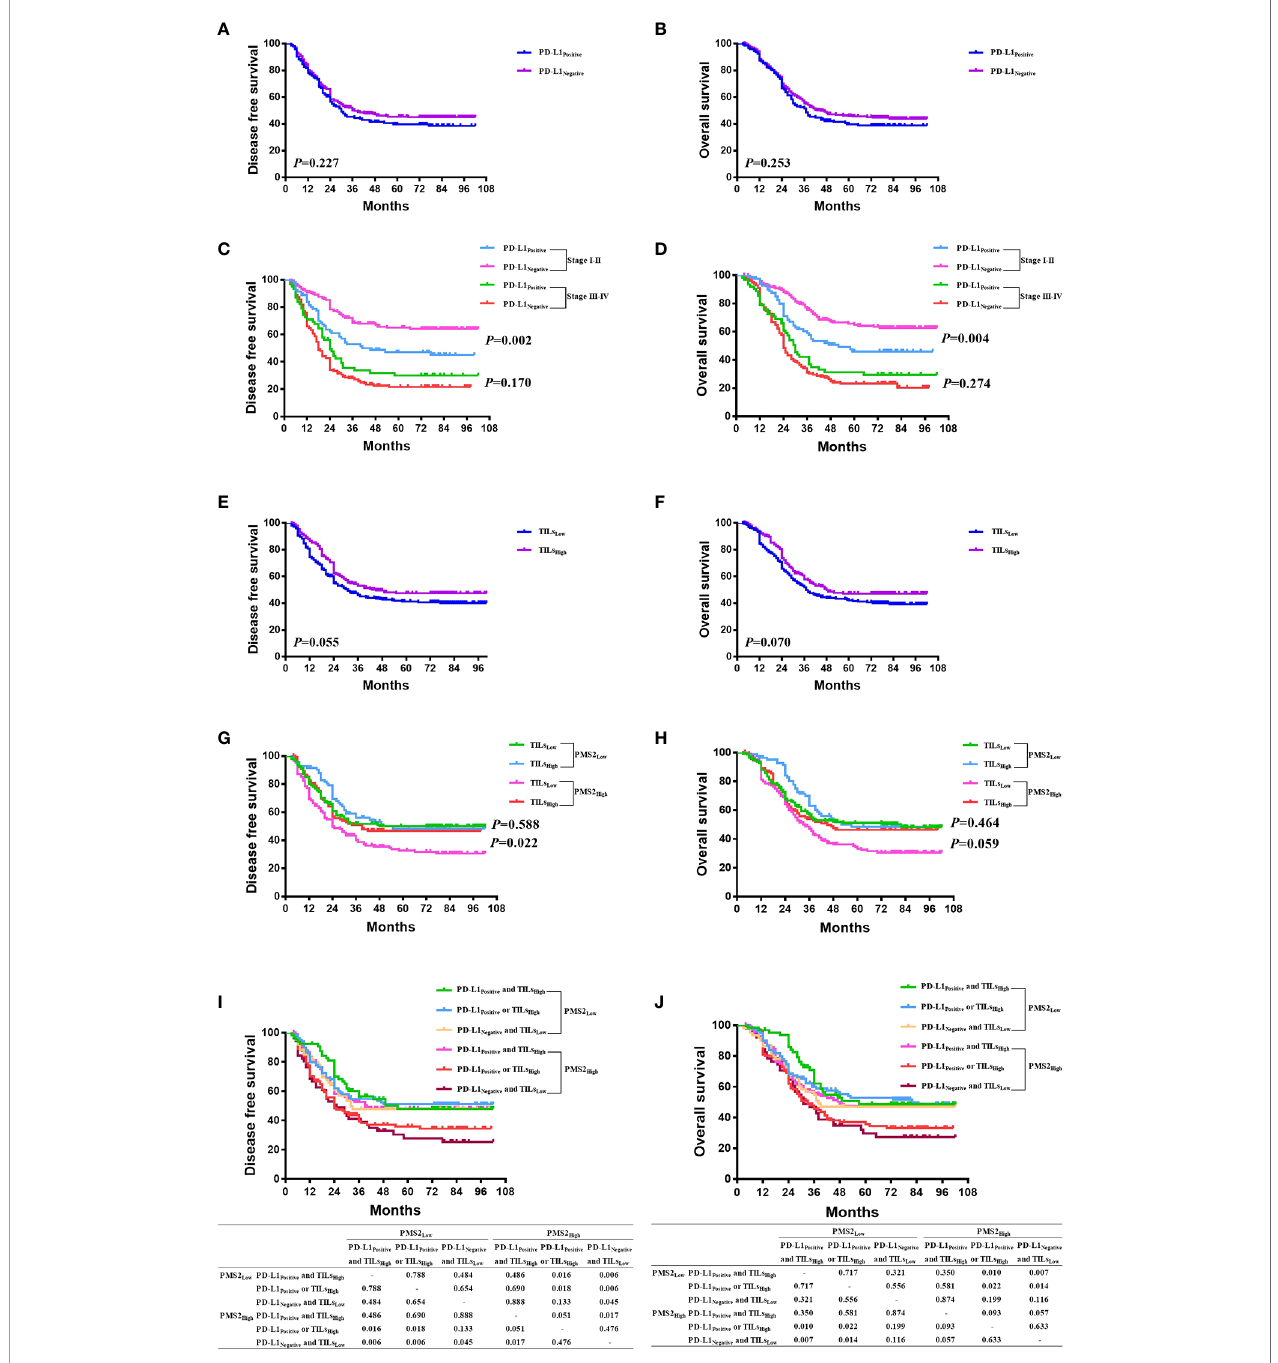
FIGURE 3 | The prognostic signi fi cance of MMR expression, PD-L1 expression, and TILs. (A, B) There was no association between PD-L1 expression and DFS or OS ( P > 0.05); (C, D) In stage I-II of disease, patients with PD-L1 expression had better DFS and OS than those without PD-L1 expression ( P < 0.05), which were not found in stage III-IV of disease ( P > 0.05); (E, F) Patients in the high-TILs group tended to have better DFS ( P =0.055) and OS ( P = 0.070) than those in the low- TILs group; (G, H) In high PMS2 expression, patients in the high-TILs group have better DFS ( P = 0.022) and OS ( P = 0.059) than those in the low-TILs group, which were not found in the low PMS2 expression group; (I, J) In 260 patients with high PMS2 expression, the order from better prognosis to poorer survival is 98 patients with both PD-L1 expression and high TILs, 111 patients with either PD-L1 expression or high TILs, and 51 patients with neither PD-L1 expression nor high TILs. However, in 224 patients with low PMS2 expression, there was no survival difference among the three cohorts ( P >